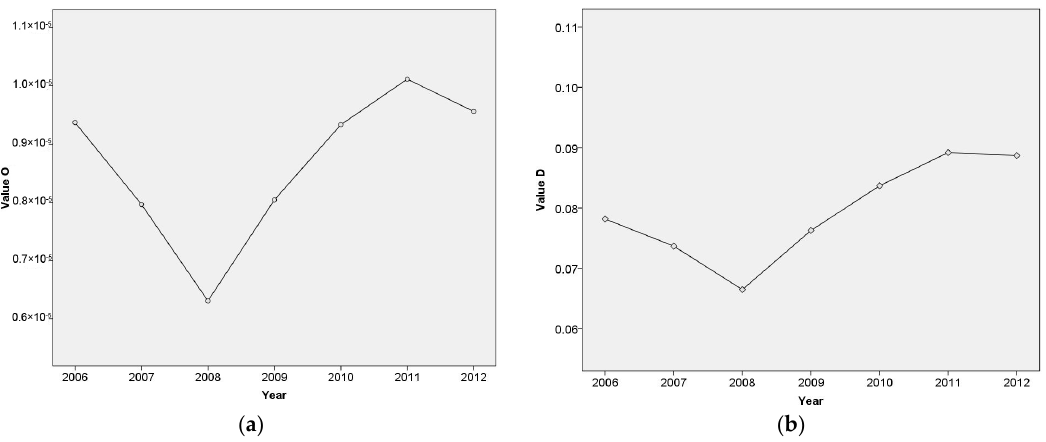
Figure 6. ( a ) Variation curve of coupling degree of built ‐ up area and emergy ‐ based ecological security index; ( b ) Variation curve of coupling coordination degree of built ‐ up area and emergy ‐ based ecological security index.